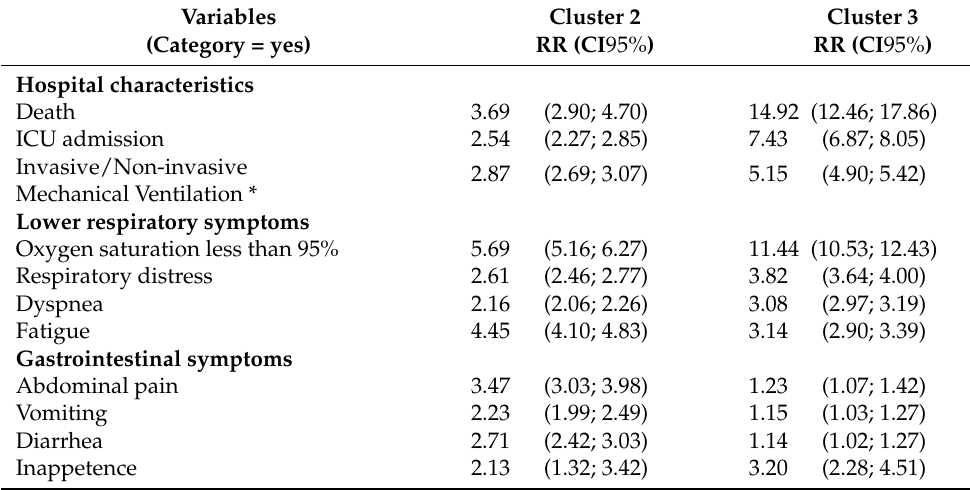
Table 3. Relative Risk (RR) with 95% confidence interval (CI) for the comparison of symptoms, comorbidities, and hospital characteristics between clusters (cluster 1: reference group) of pregnant and postpartum women with SARS due to